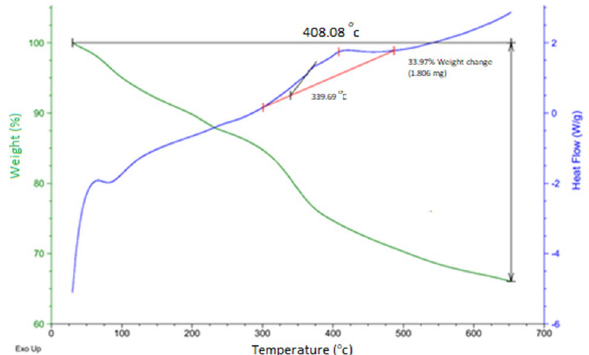
Figure 5. The TGA curve of Pd@Hal-DAB-PC.